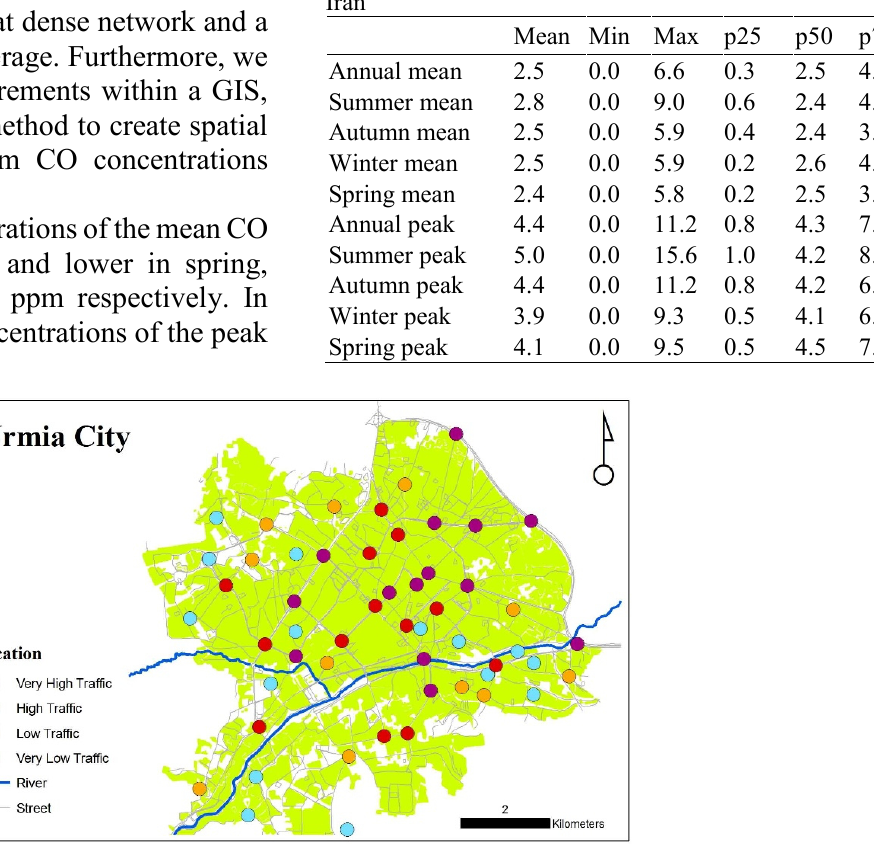
Fig. 1. Map of the 53 sampling sites based on four traffic